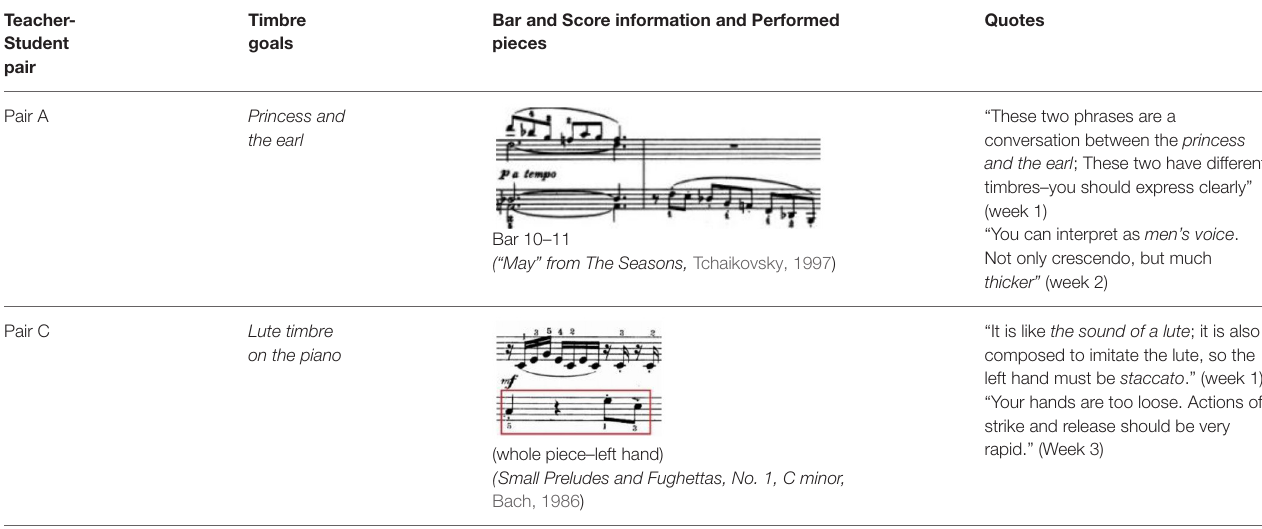
TABLE 1 | Musical excerpts and quotes of the teachers using Metaphorical Timbre. Teacher- Student